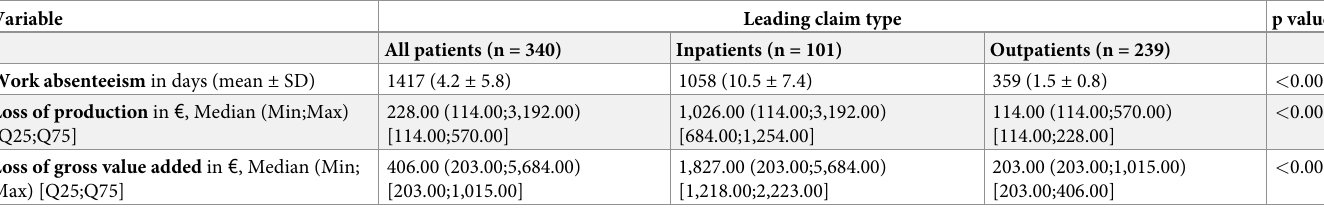
Table 4. Indirect medical